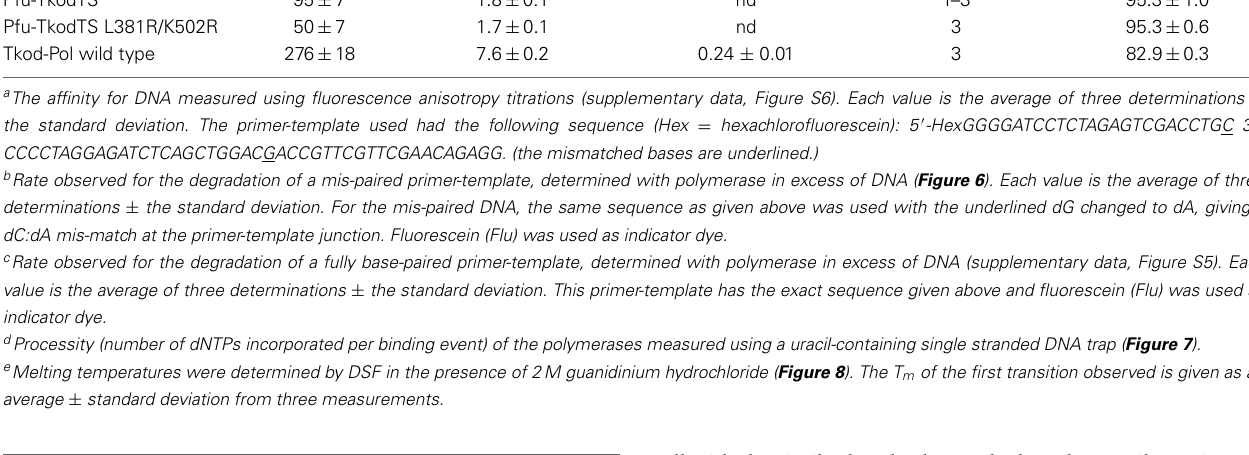
Table 3 | Fidelities of DNA polymerases determined using the lacZ α indicator